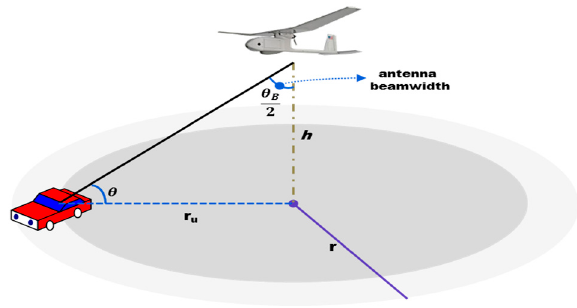
Figure 1. UAV relay coverage model .